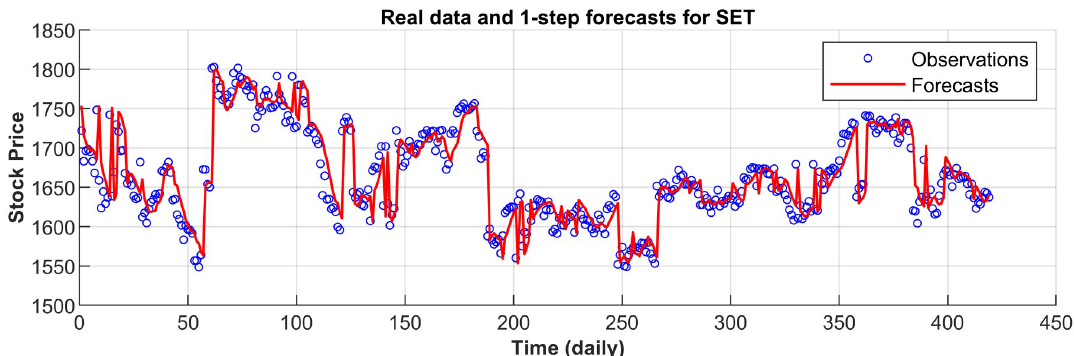
Fig 8. 1-step forecasts of the nPRM and market values for Thailand SET Index.